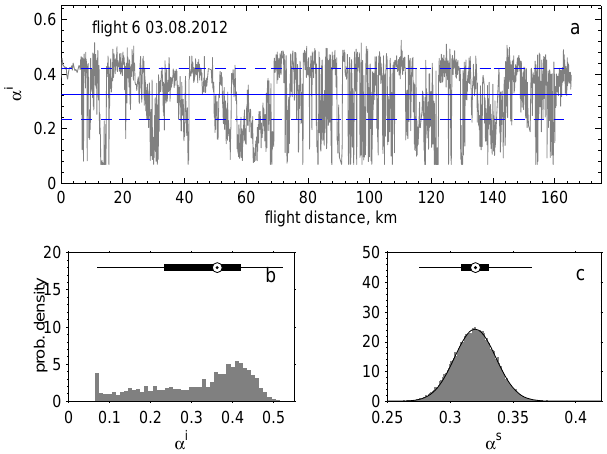
Figure 7. (a) Image-based aggregate surface albedo ( α i ) along flight track 2 shown in Fig. 3. Solid blue line is for the image- based track average albedo of 0.42, and dashed lines show the quartiles Q 1 , 3 of (0.40,0.47) of the respective α i probability den- sity shown in (b) . Note skewness of the distribution towards lower albedo values and asymmetric position of the mean with respect to the 25 and 75%; (c) bootstrap swath-based aggregate albedo α s probability density, and the solid line shows the fitted normal pdf N ( 0 . 40 , 0 . 01 2 ) . The box plots on (b) and (c) use the same conven- tions as in Fig. 4.